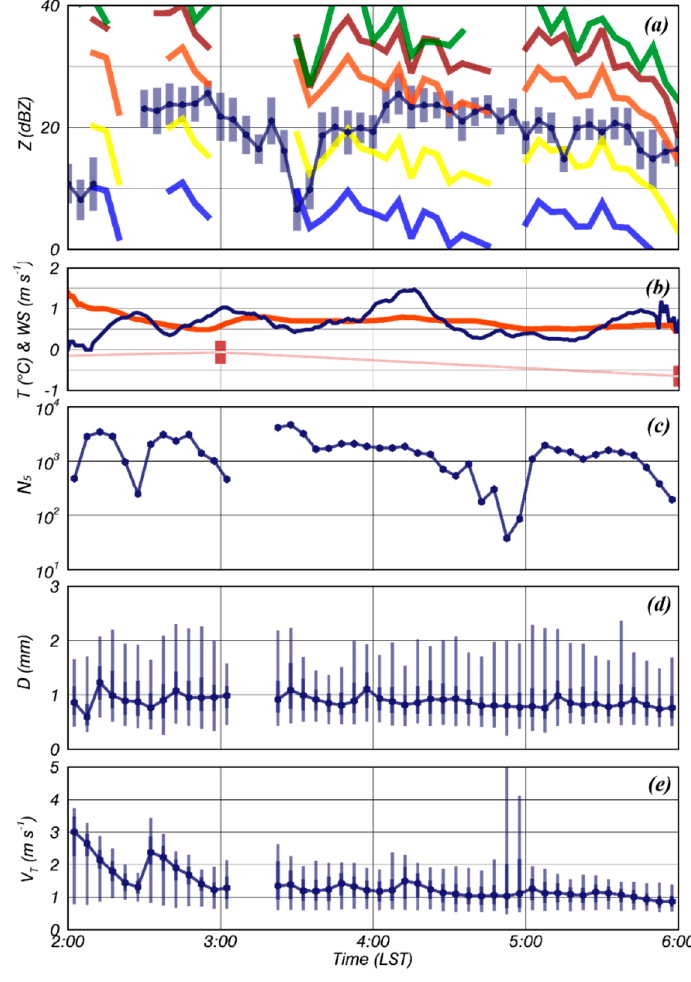
Figure 12. Time series of ( a ) Z, ( b ) T, WS, and T 6 , and physical variables in 5 min intervals observed using the 2DVD: ( c ) N 5 , ( d ) quartiles of D, and ( e ) quartiles of V T for C1 (27 February 2016). The thin solid dark blue line in Figure 12a indicates the 3 ray-5 gate averaged Z O and its standard deviation. The blue, yellow, orange, and brick colored solid lines correspond to Z S under T values of − 4 ◦ C, 0 ◦ C, 1 ◦ C, and 2 ◦ C, respectively. The green solid line in Figure 12a denotes Z S for the condition of a totally melted snowflake. The solid orange and blue lines in Figure 12b correspond to T and WS, respectively. The red solid line and vertical bar plot mean the average and standard deviation of T 6 , respectively.